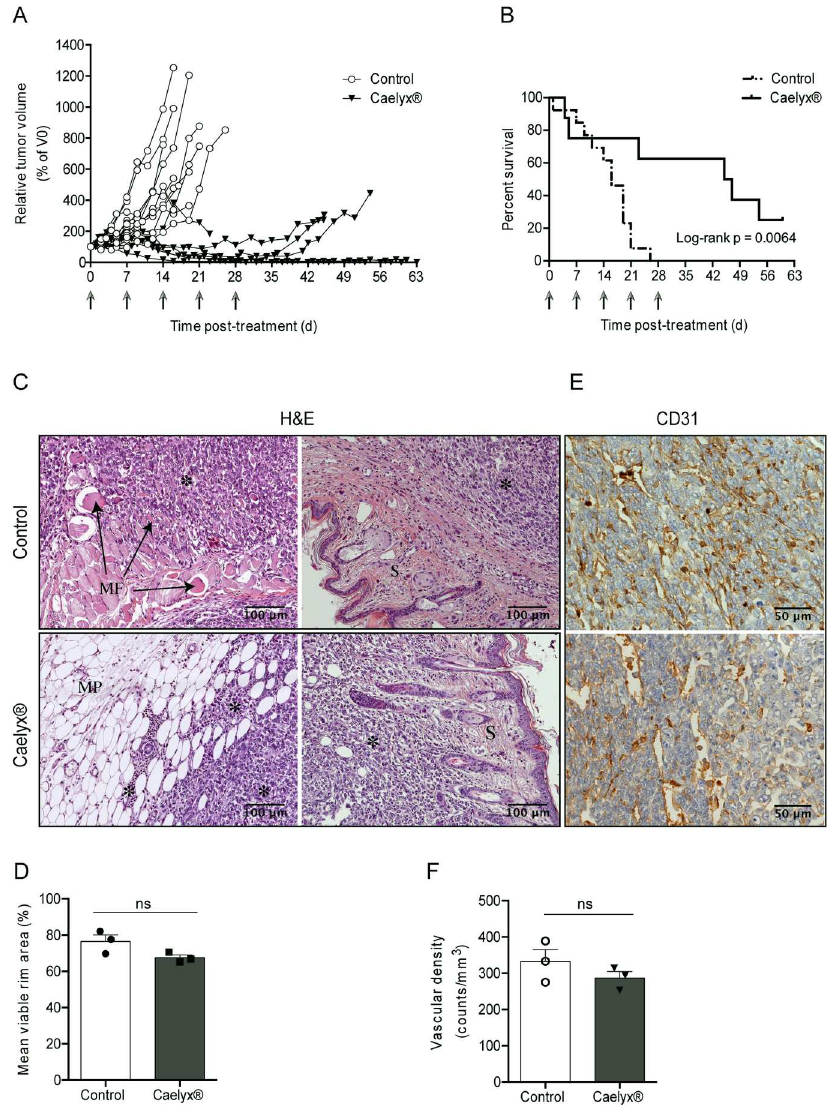
Fig 4. Therapeutic activity of Caelyx ® in 4T1 breast tumor-bearing mice. Balb/c mice implanted with 500 4T1 cancer cells in the mammary fat pad were treated weekly with Caelyx ® , at 5 mg doxorubicin/kg body weight for 5 weeks (indicated by grey arrows). An additionalcontrol group included non-treated mice (injected with saline). Individualtumor growth curves (A) and survival curves (B) are illustrated. H&E staining, originalmagnification x200 (C), quantificationof viable rim area (D), CD31 immunostaining, original magnification x400 (E), and quantificationof vascular density (F), on representative sections from 4T1 primary tumors, followingtreatment either with Caelyx ® or saline. MF, muscle fibers; S, skin; MP, mammary parenchyma; * indicatestumor areas. Data representsindividualrelative tumor volumes and median survival curves of saline- (n = 14) and Caelyx ® -treated (n = 8) mice. Viable rim area and vascular density represent mean ± SEM of 3 independent sections. ns, p > 0.05 two-tailed nonparametric Mann-Whitney